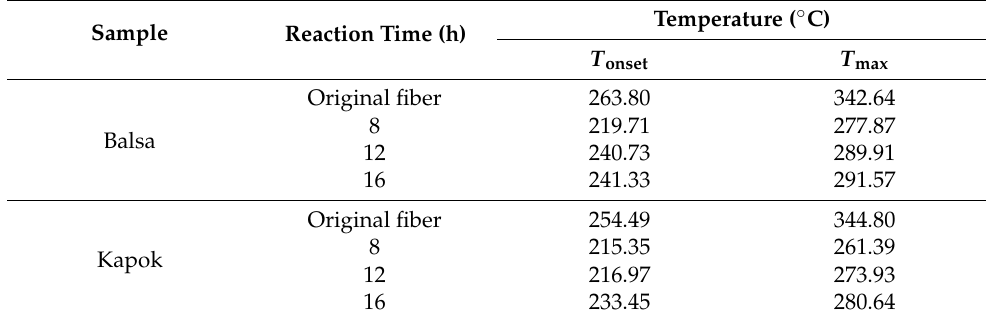
Figure 6. Thermogravimetric analysis (TGA) curves of the balsa fiber ( left ) and kapok fiber ( right ) and the resulting CNCs. Table 4. Decomposition onset temperature and maximum thermal degradation temperature ( T onset and T max ) of untreated balsa and kapok fibers and their resulting CNCs.